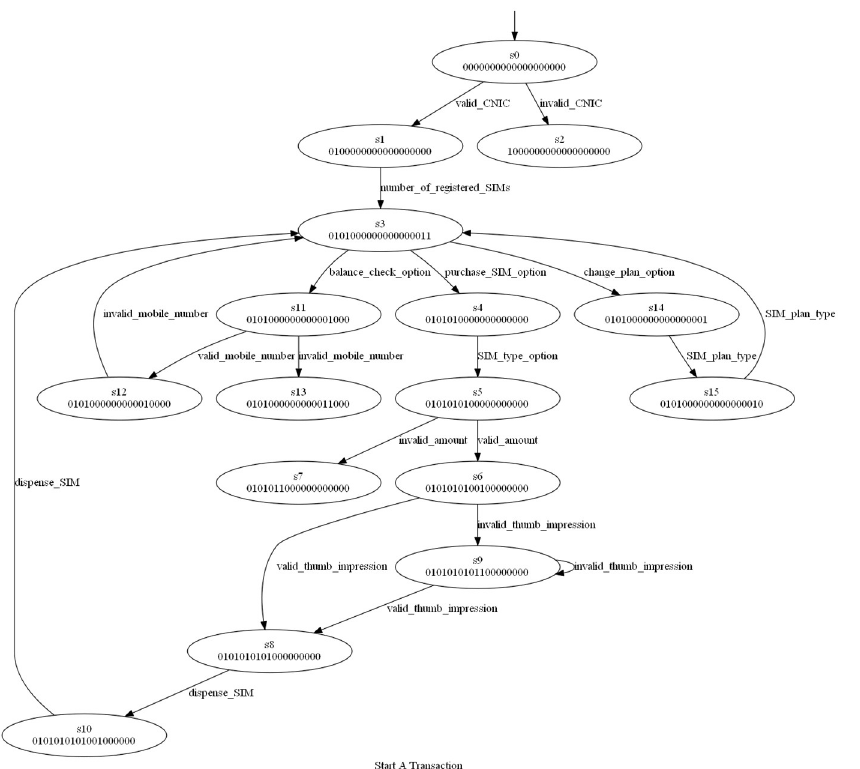
Fig 11. A SIM vending machine start a transaction Kripke